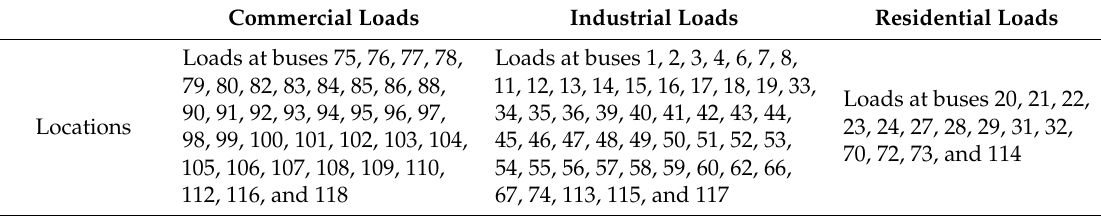
Table 2. Types of loads at di ff erent buses in the modified IEEE 118-bus